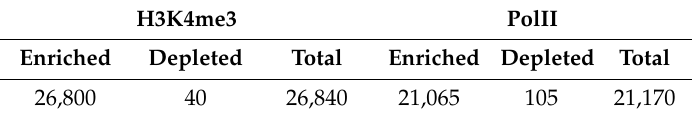
Table 5. Number of H3K4me3 and RNA polymerase II (PolII) differentially marked regions in the rice epiline LR2 versus the control